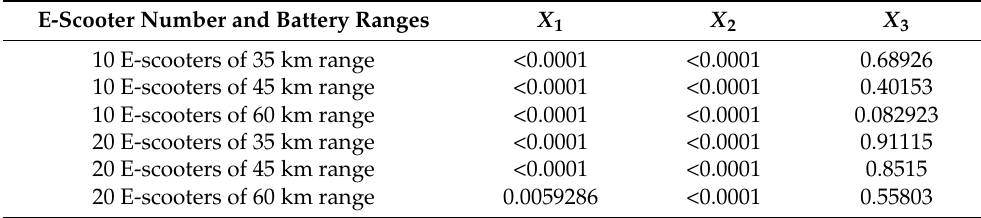
Table 6. p -values of the scenario’s indicator variables for the PSD